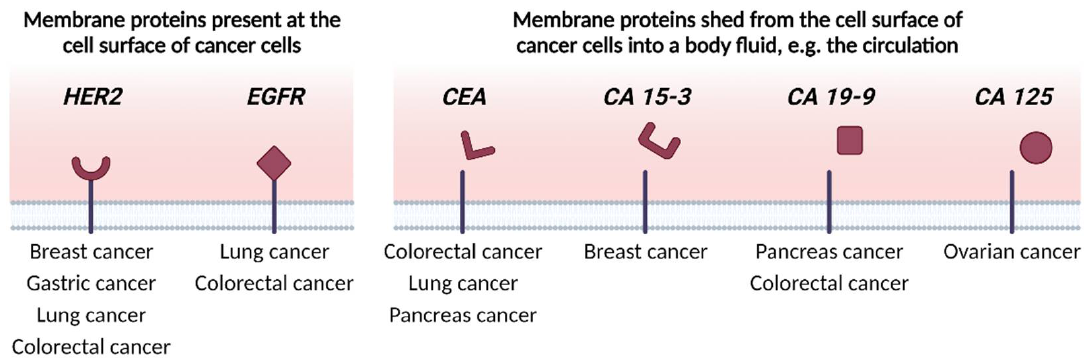
Figure 4. Examples of clinically used membrane proteins for the diagnosis, prognosis and/or treatment of different types of human cancer. Human epidermal growth factor receptor 2 (HER2) [115–122] and epidermal growth factor receptor (EGFR) [123–126] represent examples of membrane proteins that are present at the cell surface of specific cancer cells. Carcinoembryonic antigen (CEA) [127–132], cancer antigen 15-3 (CA 15-3) [133,134], cancer antigen 19-9 (CA 19-9) [127,131,135,136], and cancer antigen 125 (CA 125) [137,138] are (part of) the membrane proteins that are shed from the cell surface of cancer cells into a body fluid.